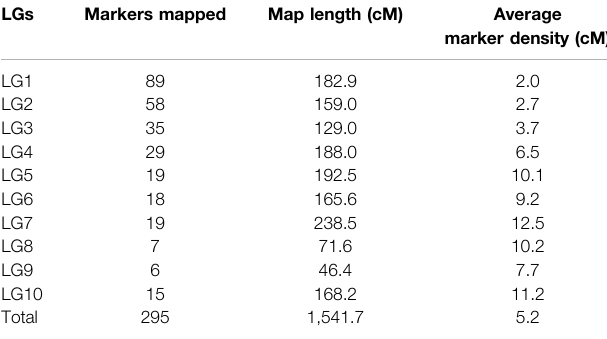
TABLE 5 | Distribution of 295 markers on ten linkage groups of an intra-speci fi c linkage map of horsegram. LGs Markers